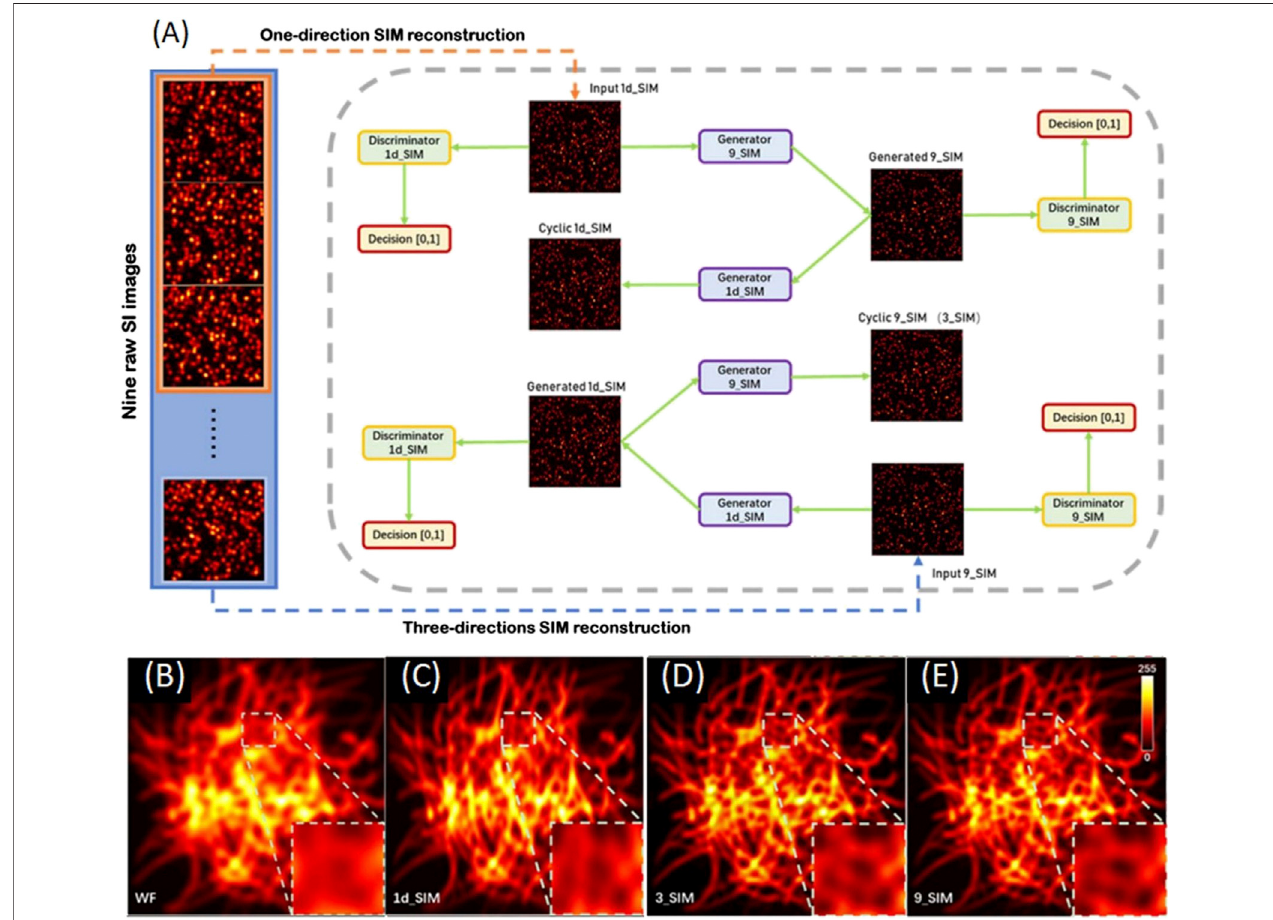
FIGURE 8 | Schematics and results of the deep neural network trained for SIM imaging [65]. (A) Deep neural network training cycles. Two training datasets are 1d_SIM and 9_SIM images as the input of two training cycles, following with two generators and two discriminators. These generators and discriminators are trained by optimizing various parameters. This loops until the generated images are accepted by the discriminator. (B – E) Deep learning-enabled transformation of images from 1d_SIM to 9_SIM. The 3_SIM image generated by the deep neural network in (D) is matched to the 9_SIM image in (E) . Figures are modi fi ed with permission from Ref. (65). Copyright © 2020 Chinese Laser